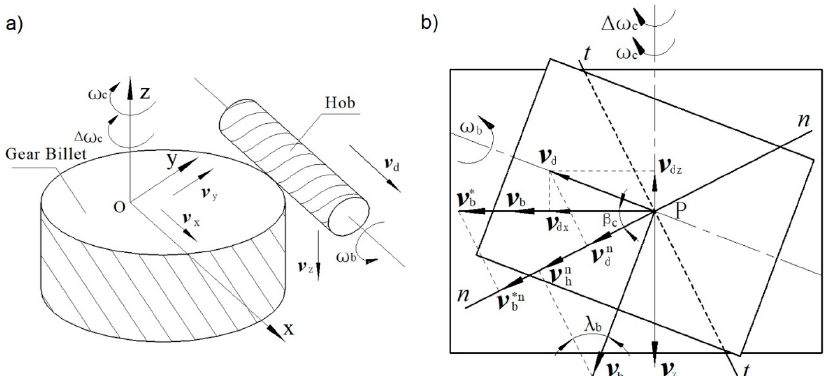
Figure 6. ( a ) Schematic diagram of the hobbing process; ( b ) common tangent plane of hobbing. ω c : angular velocity, ∆ ω c : extra angular velocity, v d : diagonal feed rate, v : velocity, ω b : lead angle, β c : helical angle [12].